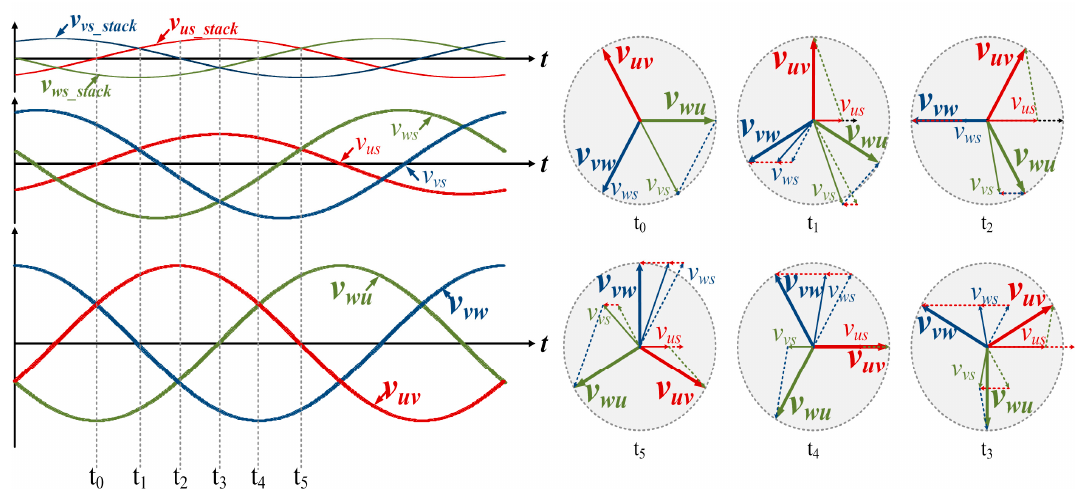
Figure 5. Vector diagram according to time applying the conventional neutral-point voltage-shifting control in case of stack failure.